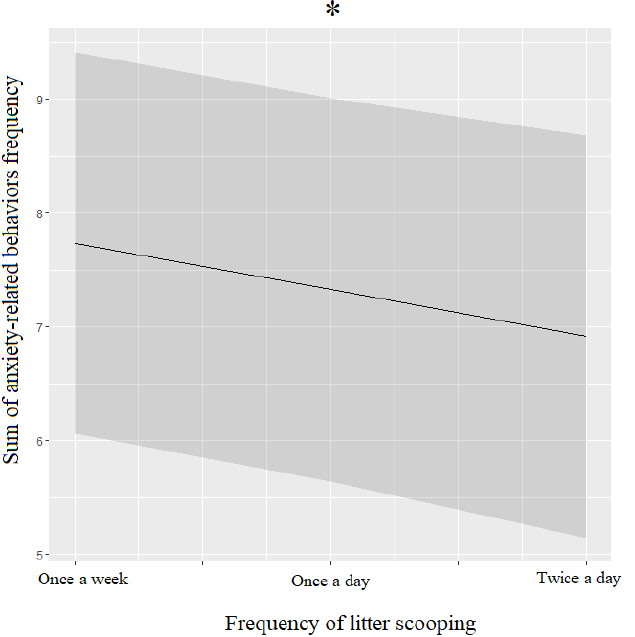
Figure 7. Means and 95% confidence intervals of cats’ anxiety-related behaviors’ frequency depending on the frequency of litter scooping extracted from linear mixed-effect model (LMM). *: p < 0.05, Wald chi-squared test.